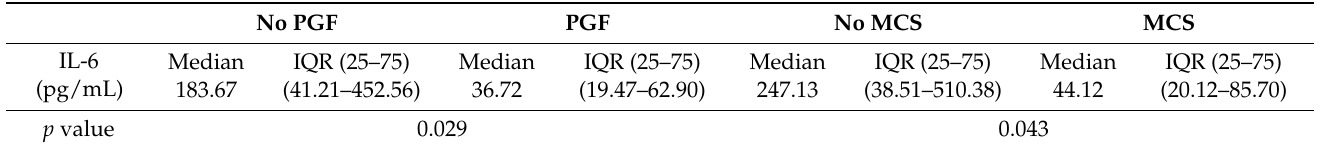
Table 3. Relationship between donor’s pericardial interleukin-6 and postoperative complications.